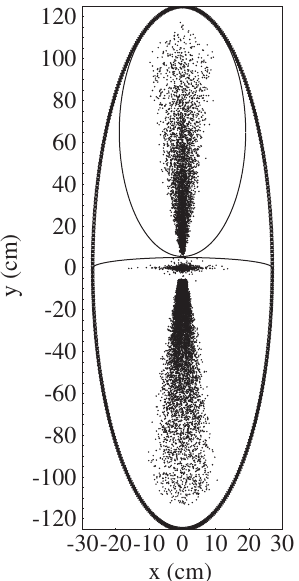
FIG. 10. Transverse beam profiles obtained in the separation region, 67 m downstream of the interaction point.